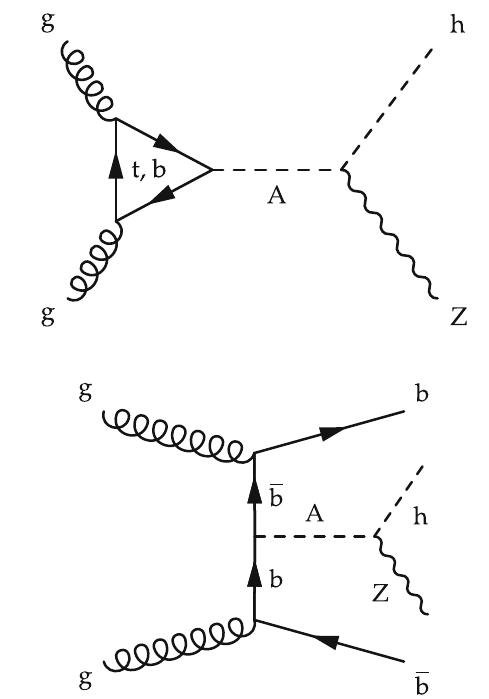
Fig. 1 Representative Feynman diagrams of the production in the 2HDM of a pseudoscalar A boson via gluon–gluon fusion (upper) and in association with b quarks